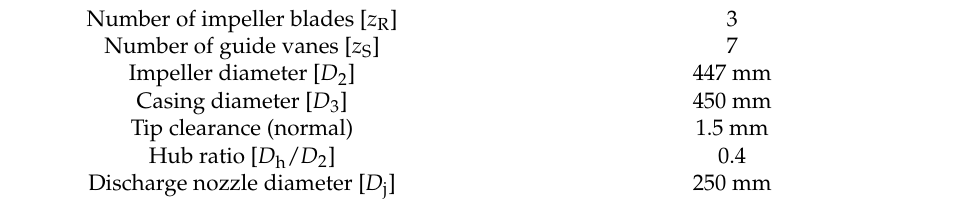
Table 1. Main geometric parameters of an axial waterjet